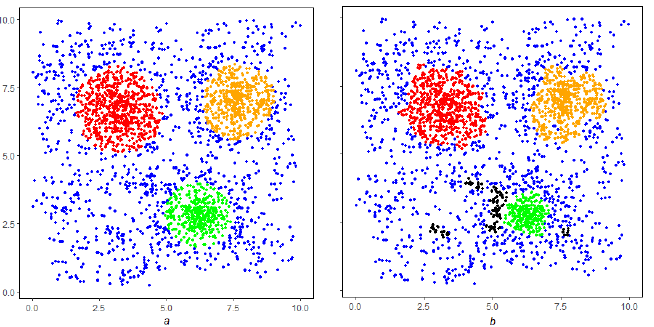
Figure 4. Direct dependence on the radius of localization of the first stage of SDPS when moving from SDPS ( α , r , p )( X ) ( a ) to SDPS ( α , ¯ r , p )( X ) ( b ) with r > ¯ r on the array X (Figure 3a). Finer black condensations were added to the red, yellow and green ones.